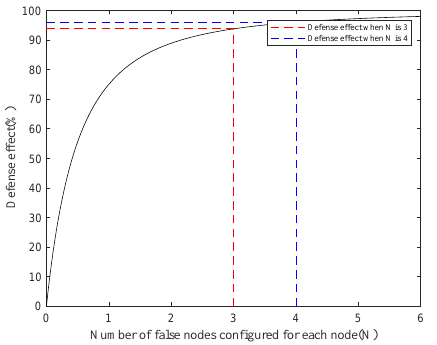
Figure 4. The effect of false nodes with a different